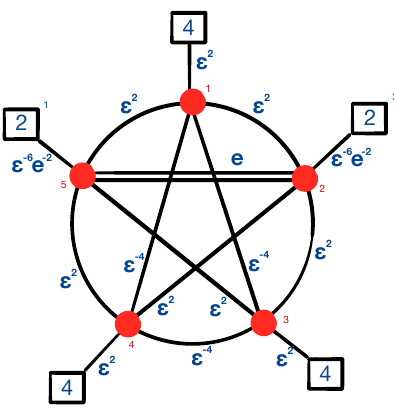
Figure 2 . Going on the conformal manifold we necessarily break some of the symmetry. A sublocus of the conformal manifold which is easy to identify is the one on which the ten abelian symmetries are broken to U(1) (cid:15) (cid:2) U(1) e denoted on the quiver. The three SU(4) symmetries are broken to diagonal USp(4). The three SU(2) symmetries are not broken. One turns on superpotentials consistent with the charges in the